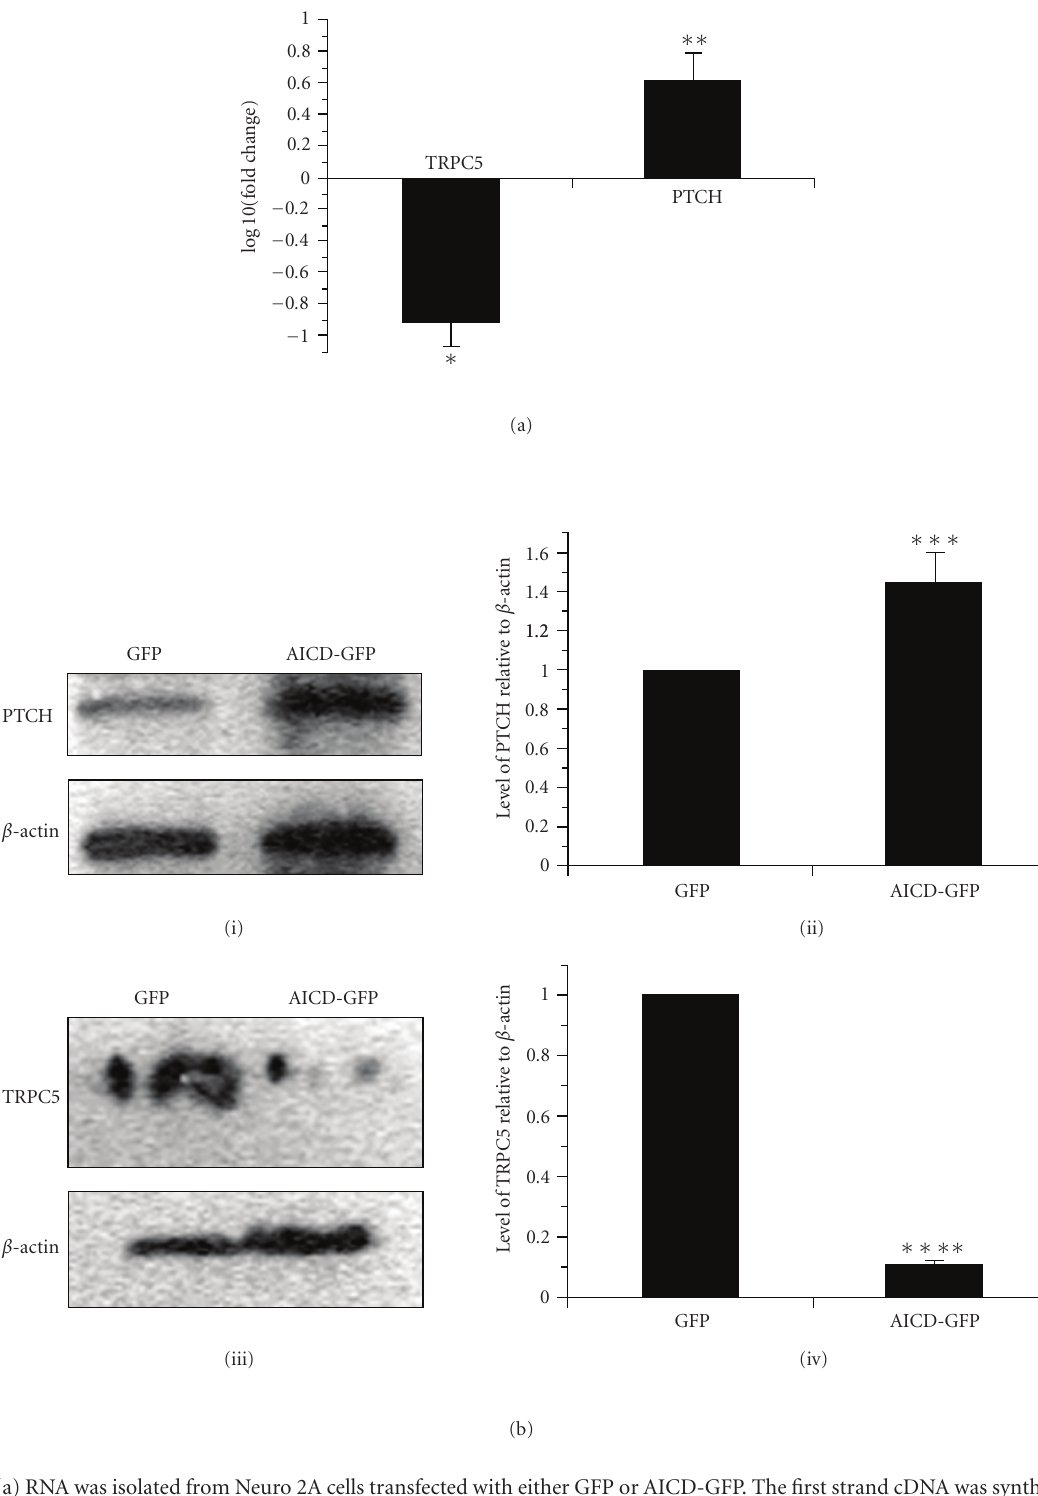
Figure 1: (a) RNA was isolated from Neuro 2A cells transfected with either GFP or AICD-GFP. The first strand cDNA was synthesized using random hexamer primers and reverse transcriptase. Using that c-DNA as template, expression of PTCH1 and TRPC5 were also checked by real-time PCR in both the cell lines. The relative quantification of both the genes in AICD-GFP transfected cell compared to only GFP transfected cell were expressed in terms of 2 − ΔΔ Ct values after normalization with respect to internal control (beta-actin gene) and plotted in log scale (log10(Fold change)) ∗ indicated P < . 02 and ∗∗ indicated P < . 05. (b) Proteins were prepared from both GFP and AICD-GFP transfected cells after 24 hours of transfection, run on SDS-PAGE and western blot was done with antibody against PTCH1 (i) as well as TRPC5 (iii) and beta actin as loading control in both the cases. Fold change was calculated by densitometry analysis taking beta-actin as loading control (ii) and (iv). ∗∗∗ indicated P < . 05 and ∗∗∗∗ indicated P < .